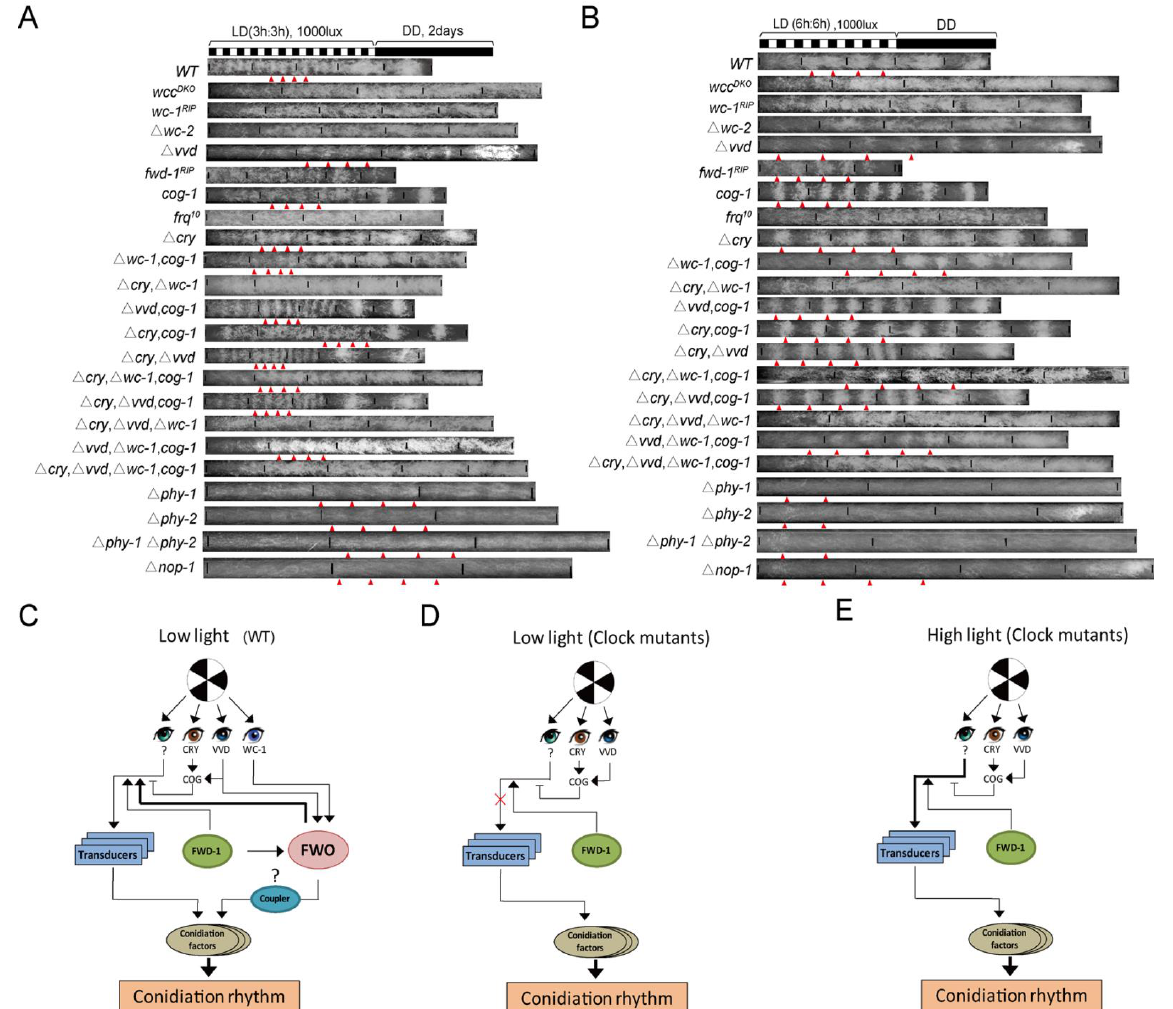
Figure 5. Conidiation rhythms in low white light (1000 lux). ( A , B ) Race tube results of conidiation rhythms of indicated strains in LD3:3 ( A ) and LD6:6 ( B ). Representative results are shown ( n ≥ 3). The white light intensity was 1000 lux. Triangles denote the conidiation bands. ( C – E ). Schematics of the control of conidiation rhythms under short LD cycles of WT in low-intensity light ( C ) and clock mutants in low-intensity light ( D ) and high-intensity light ( E ). WC-1, VVD and additional photorecep- tor(s)are implicated in the regulation of the conidiation rhythms. In 6 h≤ T ≤ 24 h, the FWO system is entrained, and the FRQ rhythms are not endogenous as they cannot be maintained in constant dark. The question masks denote unidentified photo- receptor and putative coupler linking FWO and conidiation, respectively. Transducers denote the factors linking photorecep- tor and conidiation.